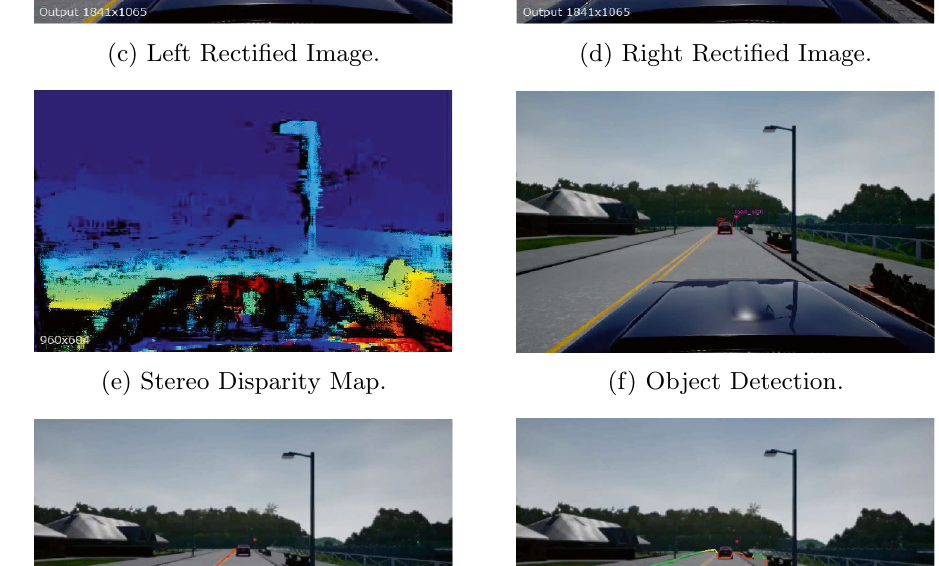
(g) Lane Detection. (h) Free Space